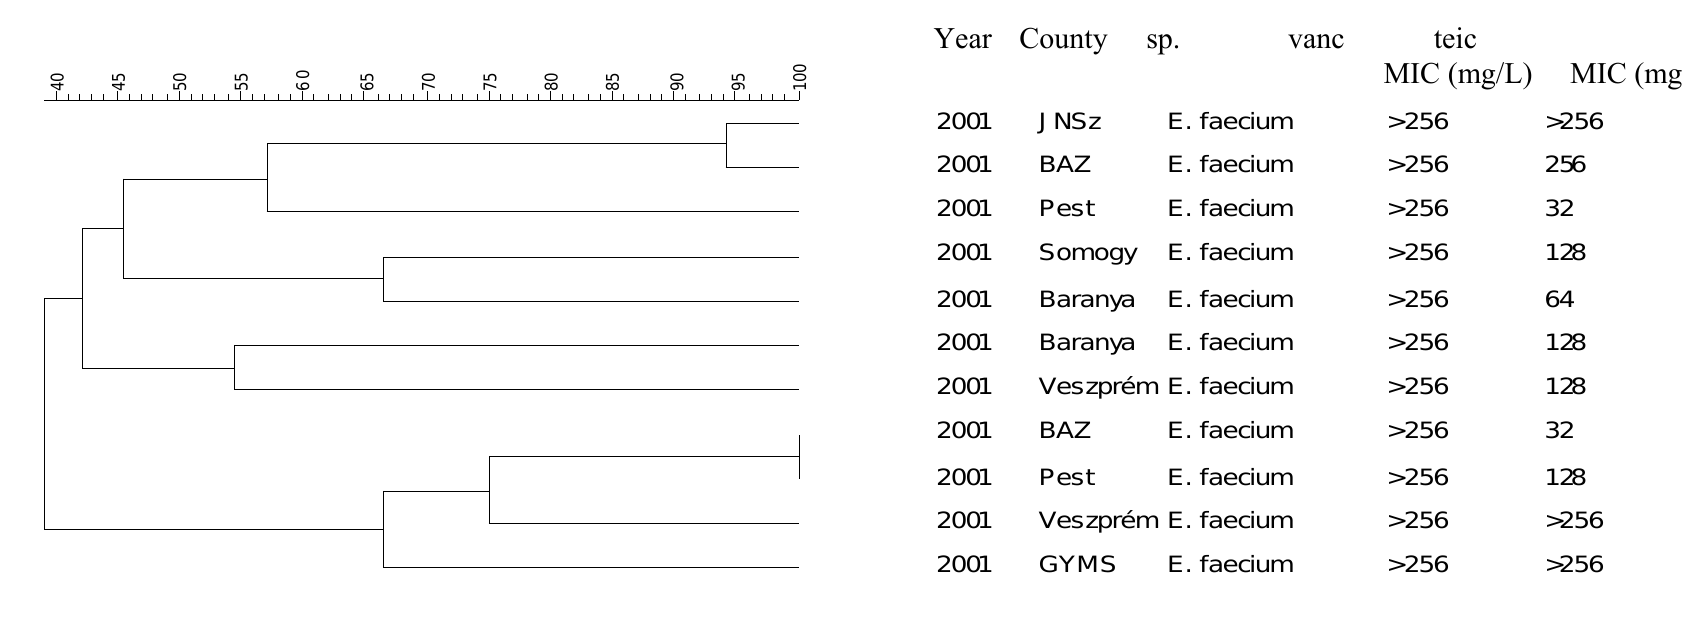
Figure 16. Dendrogram of vancomycin-resistant E. faecium strains isolated from chicken in 2001